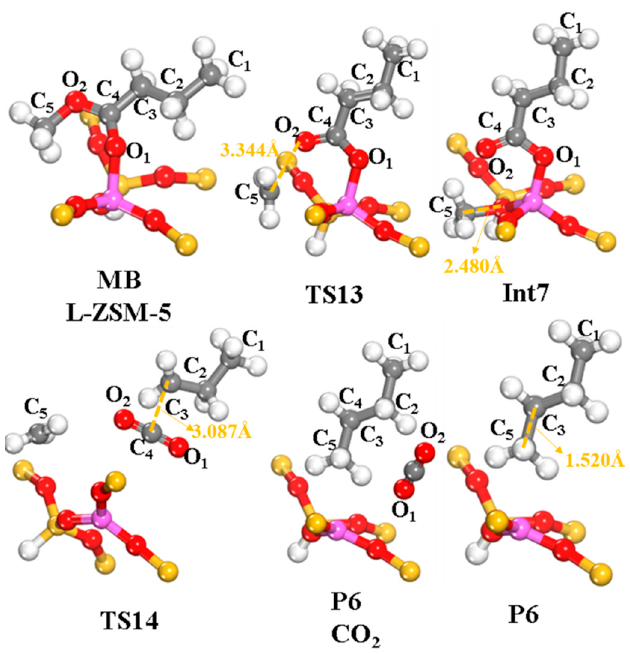
Figure 6. The structures of initial, transition, and final states for the β -C － O bond cleavage of MB on 32 T cluster of ZSM-5.